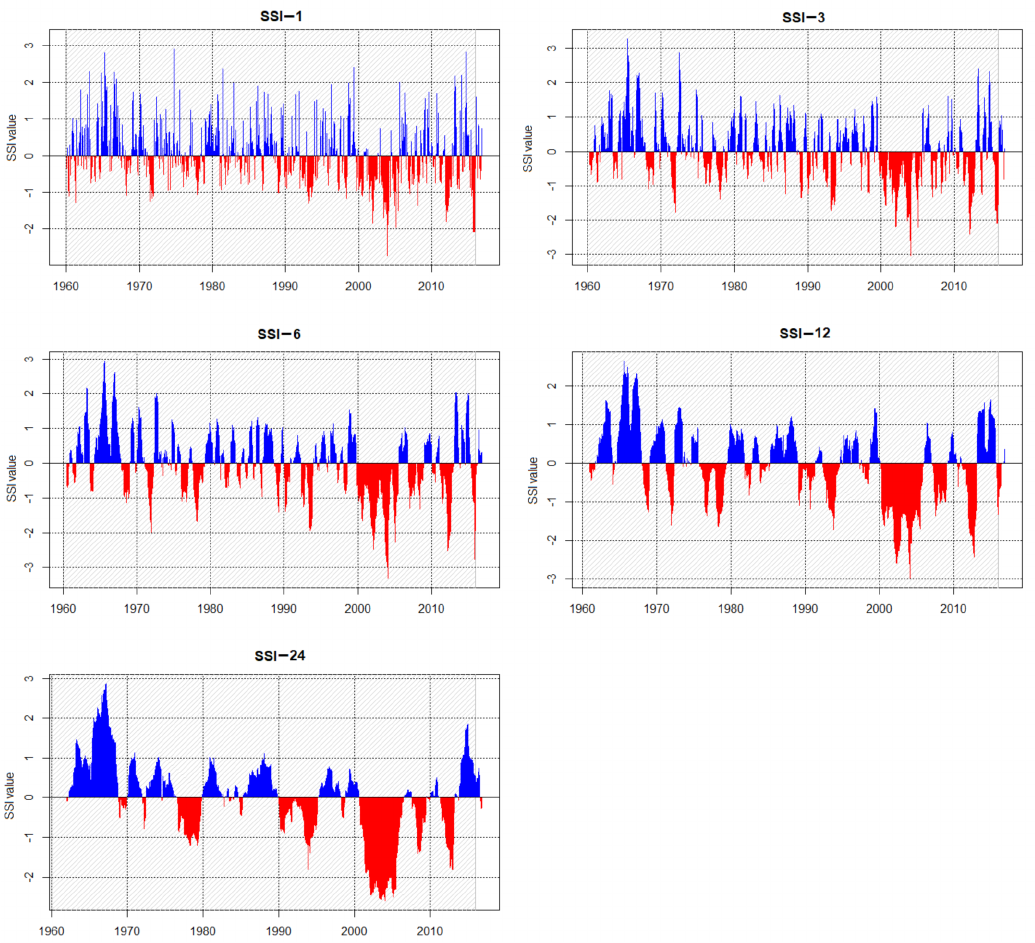
Figure 2. Example of the SSI results at various time scales for the gauging station Polana I